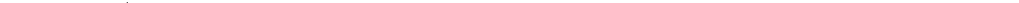
group(See figure on next Fig. 3 MEP effects on adipose tissue (epididymal) histology, lipogenic and adipogenic gene expression. Adipocyte morphology was analyzed by H&E staining and the size of the adipocyte was estimated via ImageJ software. 100 mm scale bar. A The variations of adipocyte histology in different treatment groups are shown in H & E images. B Adipocyte area distribution suggests that HFD has a larger area of adipocytes (> 20,000 mm 2 ). In comparison, the MEP-supplemented groups showed smaller adipocytes (20,000 mm2) in size. C qRT-PCR was used to determine the effect of MEP treatment on the mRNA expression levels of lipogenic and adipogenic genes PPARy, aFABP, FAS, CD68, and F4/80 in adipose tissue. Data are presented as mean SEM (n 8). By using One-way analysis of variance (ANOVA) with Tukey’s multiple comparison, Significant differences were ± = presented using at # p < 0.05, ## p < 0.01, ### p < 0.001, # ### p < 0.0001 vs. Control group and *p < 0.05, **p < 0.01, *** p < 0.001 **** p < 0.0001 vs. HFD